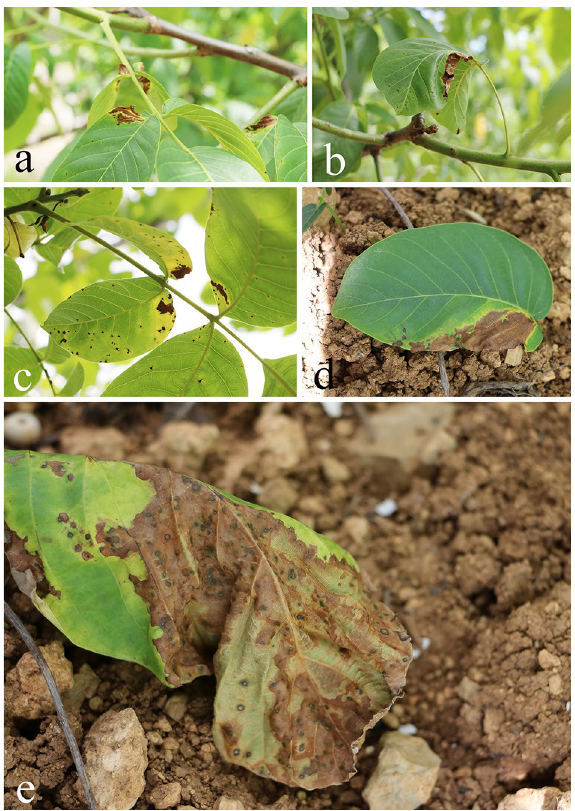
Figure 1. Disease symptoms of leaves on Juglans regia in the field. ( a – c ) Leaf brown necrosis symptoms; ( d ), Local leaf blight due to enlargement of the spot; ( e ) Leaf withered and fallen with severe